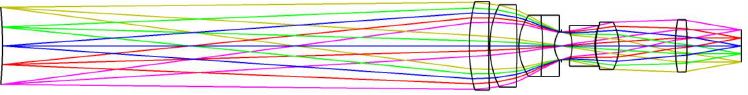
Figure 8. Image-space telecentric relay imaging group layout.